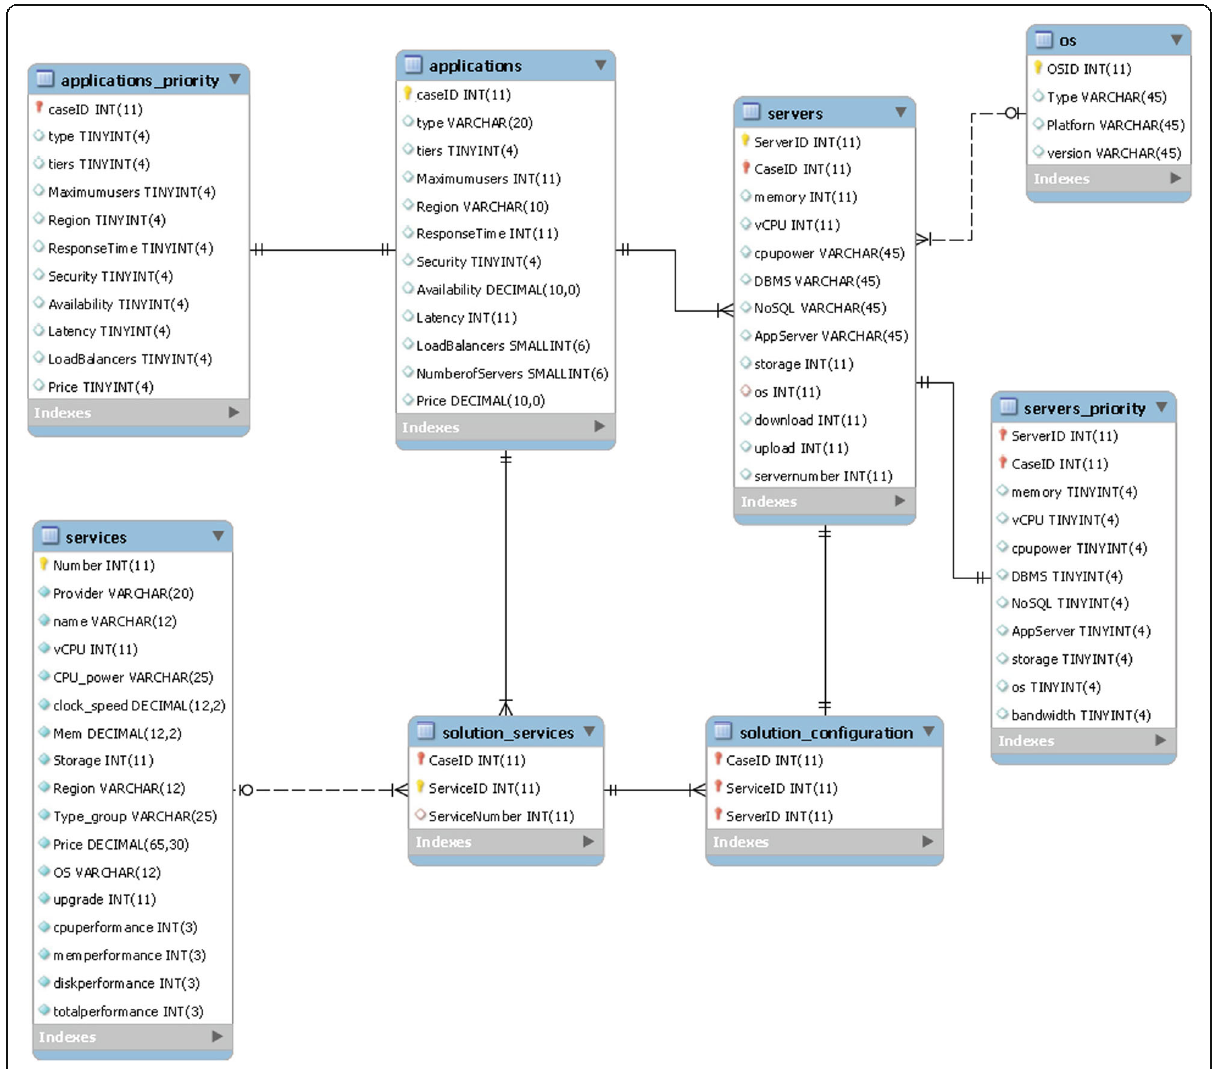
Fig. 4 The EER schema of application case